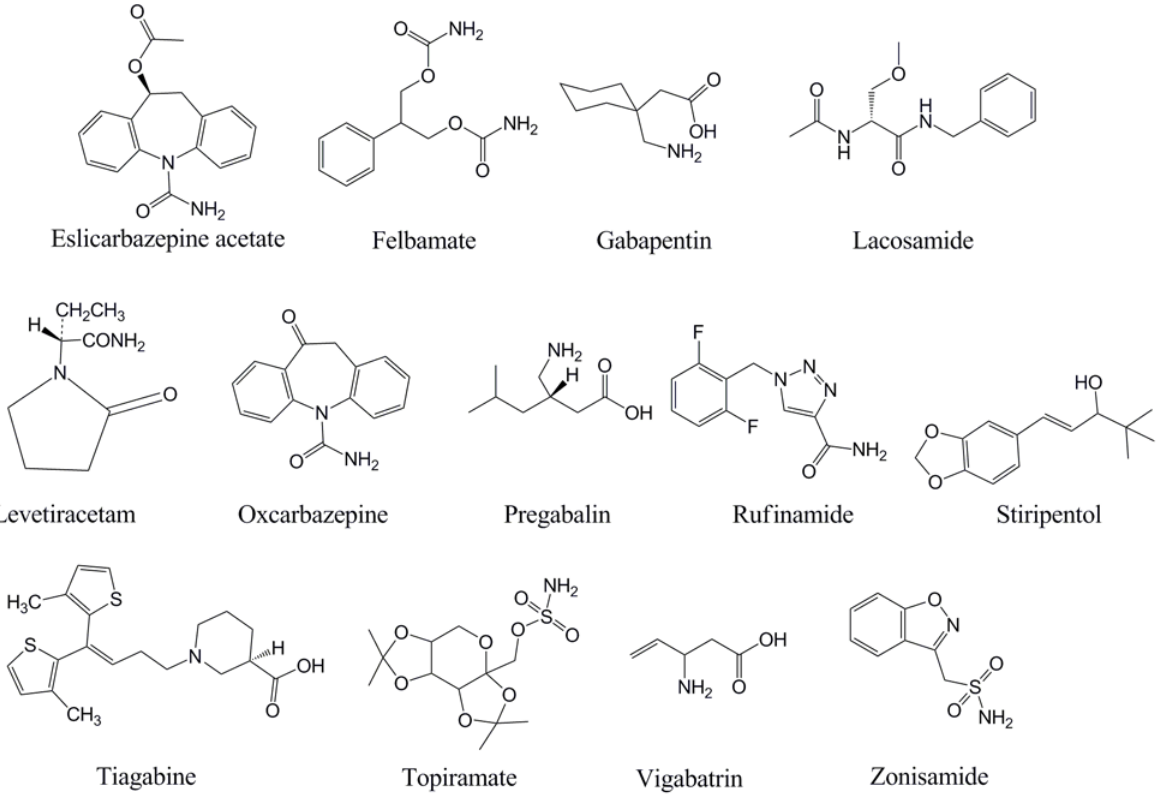
Figure 1 . Chemical structures of the antiepileptic drugs discussed in this